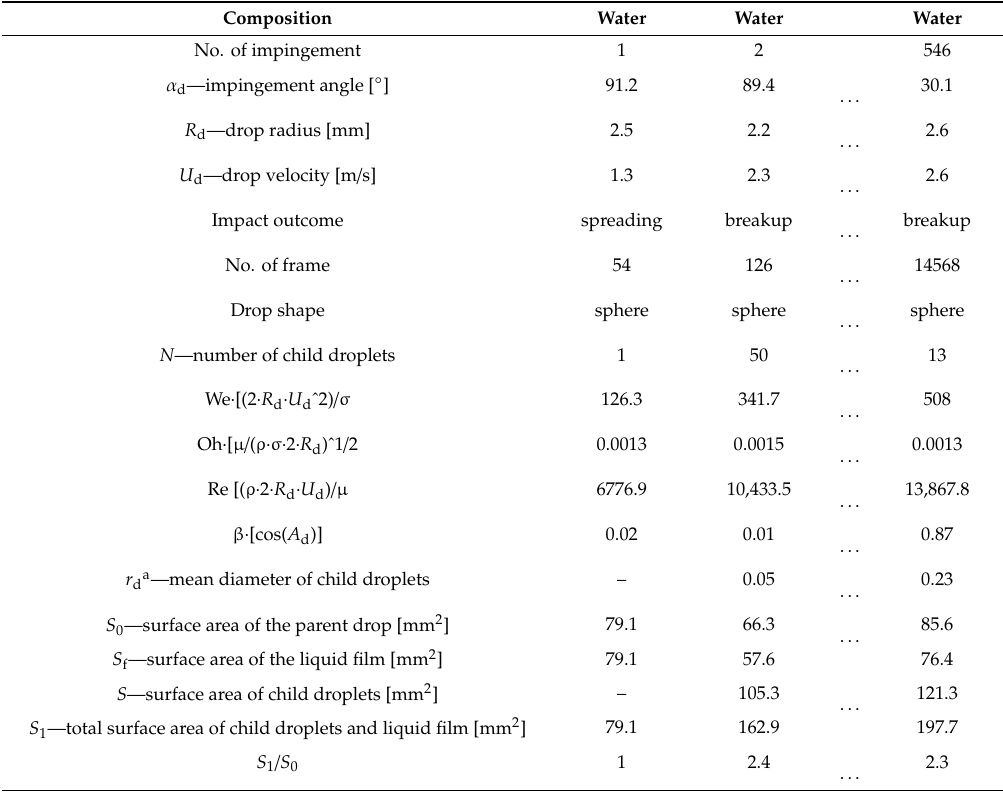
Table 2. Recorded and calculated parameters of the drop